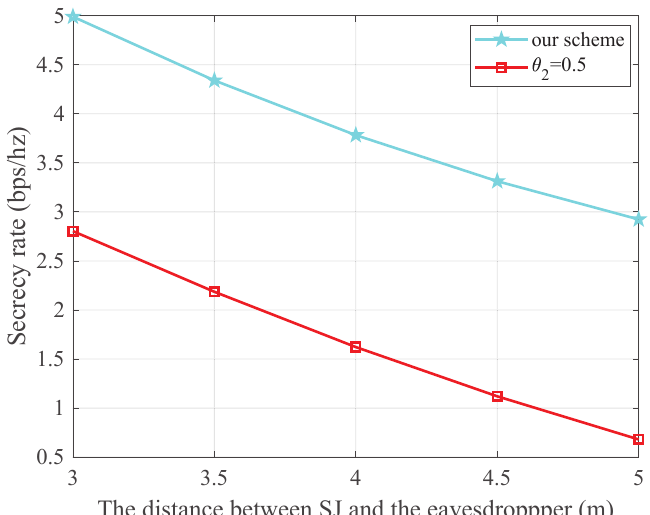
Figure 8. The secrecy rate versus the distance between SJ and the